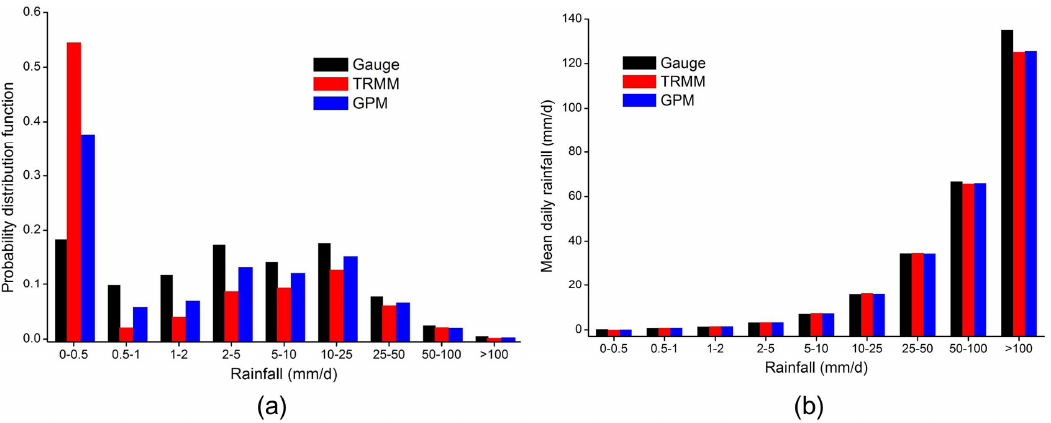
Figure 8. Probability distribution function ( a ) and mean daily precipitation ( b ) at different rainfall thresholds.